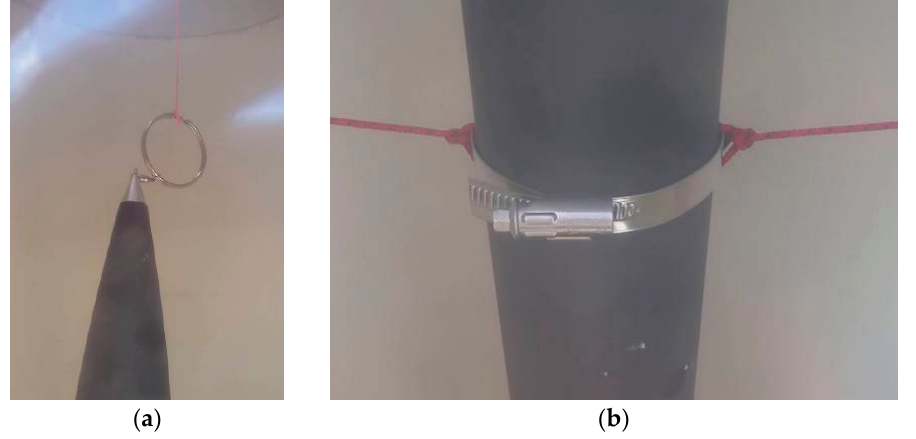
Figure 9. Stability set up ( a ) connection to string; ( b ) connection to center of mass of rocket.